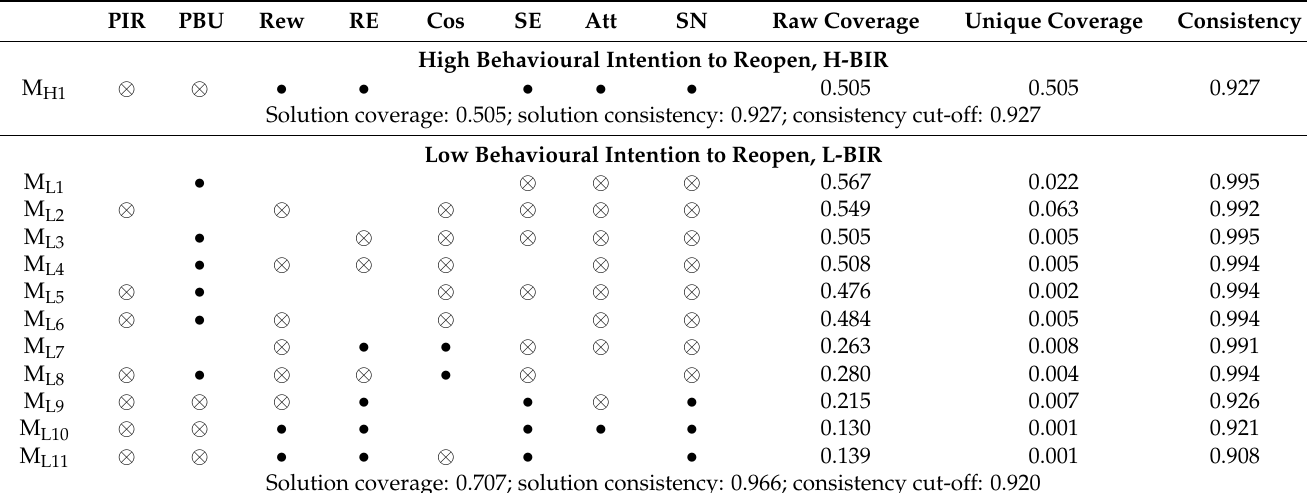
Table 7. Causal configurations for high and low behavioural